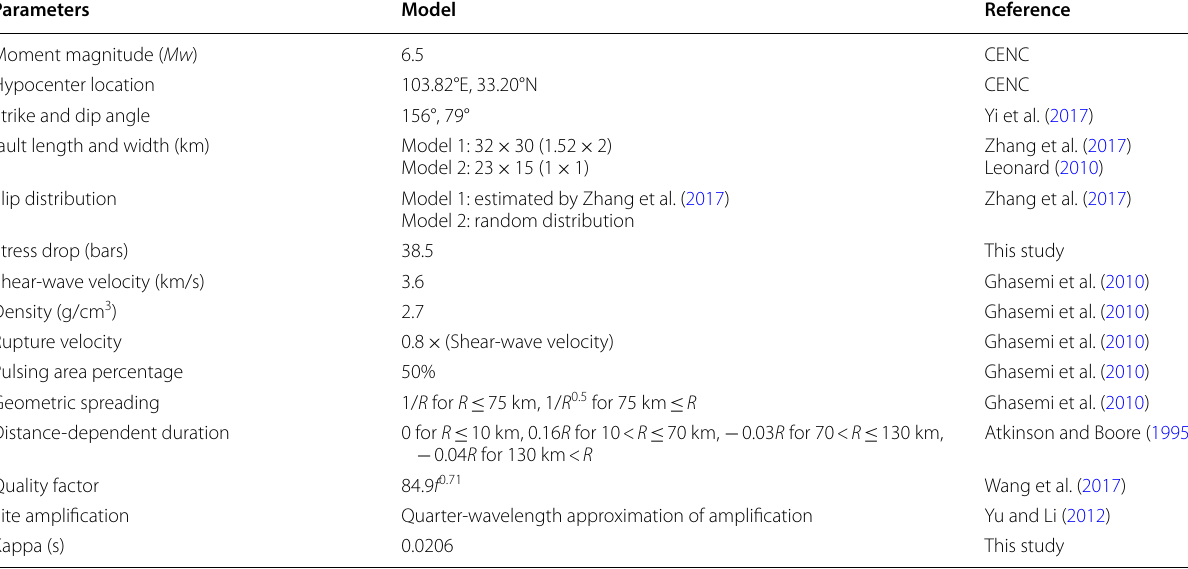
Table 2 Input parameters for the stochastic finite‑fault model of the Jiuzhaigou earthquake